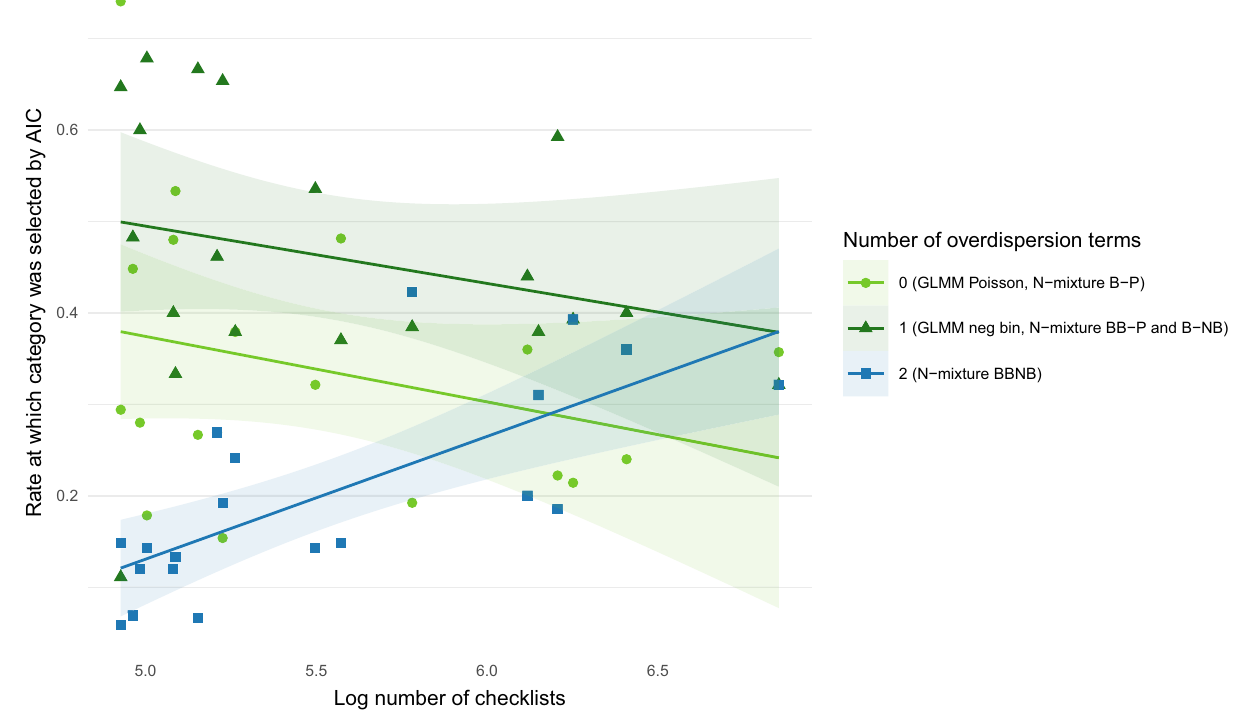
Figure 2. For each subregion, we plot the proportion of each model group selected for each of three model flexibility categories against the number of checklists in that subregion. Solid lines show best fit lines for each category. As the number of checklists in a subregion is increased, the most flexible BB-NB N-mixture model is supported at an increasing rate.